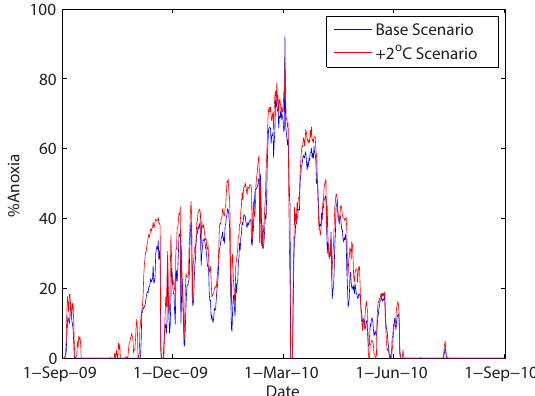
Fig. 12. Time series of percent anoxia in the Yarra River estuary: blue – simulated by 3-D model under 2009–2010 climate; red – simulated by 3-D model under + 2 ◦ C climate change.